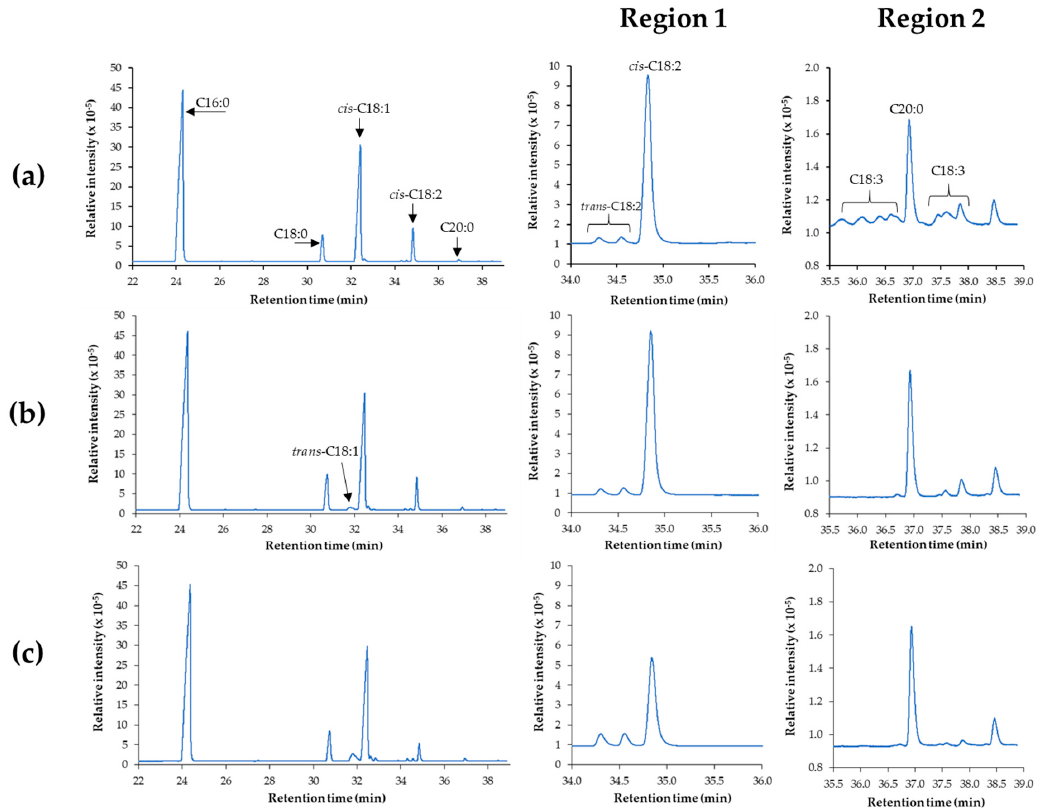
Figure 5. GC-chromatograms of ( a ) FAME and H-FAME obtained from ( b ) 30 wt% Ni/SB (C18:2 conversion conversion = 26.9%) and ( c ) 30 wt% Ni / SF (C18:2 conversion = 71.3%) (Region 1: peaks of C18:2 and = 26.9%) and ( c ) 30 wt% Ni/SF (C18:2 conversion = 71.3%) (Region 1: peaks of C18:2 and Region 2: peaks of Region 2: peaks of C18:3 and C18:3 and C20:0).